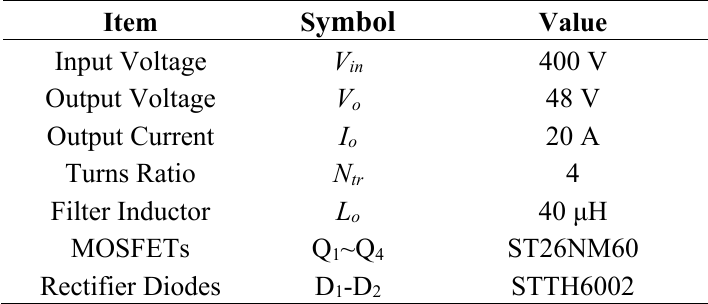
Table 1. Specifications of the